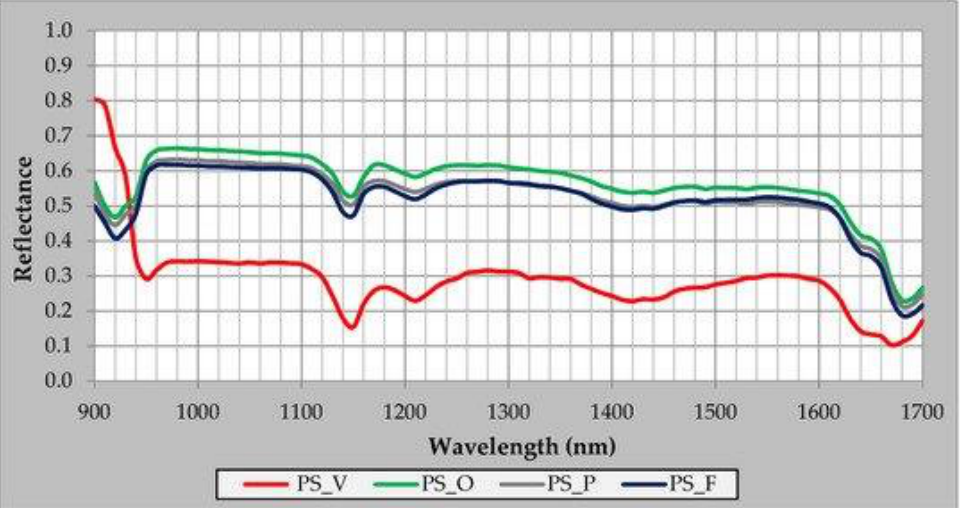
Figure 8. The NIR spectra of PS samples were obtained by a linear spectrometer, where (V) are virgin particles, (O) represents the original shape of waste, (P) are large pieces, and (F) are flakes. Reprinted with permission from ref. [21].